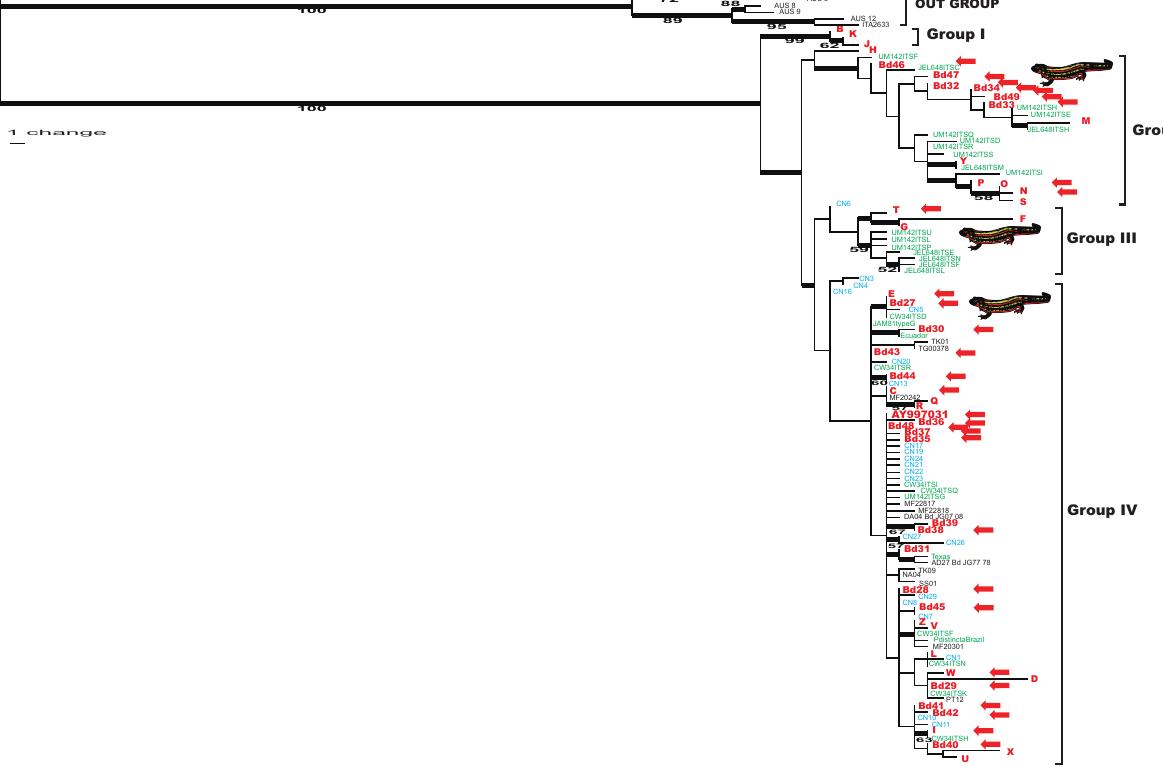
Figure 2. Phylogenetic tree of the ITS haplotypes of Batrachochytrium dendrobatidis , generated by using maximum-parsimony analysis. The numbers under the branches are the parsimony bootstrap support values for values greater than 50%. The numbers above the branches represent the lengths of the branches. Red text indicates haplotypes detected in Japan (50 types); blue text indicates sequences detected in China (21 types) [34]. Green text indicates sequences detected in North and South America (31 types) [26]; black text indicates sequences detected in the USA, Ecuador, and Italy (12 types) [32]. The red arrows indicate haplotypes of Bd ITS-DNA on C. ensicauda (30 types), indicating that all group strains of Bd except group I have been detected from the